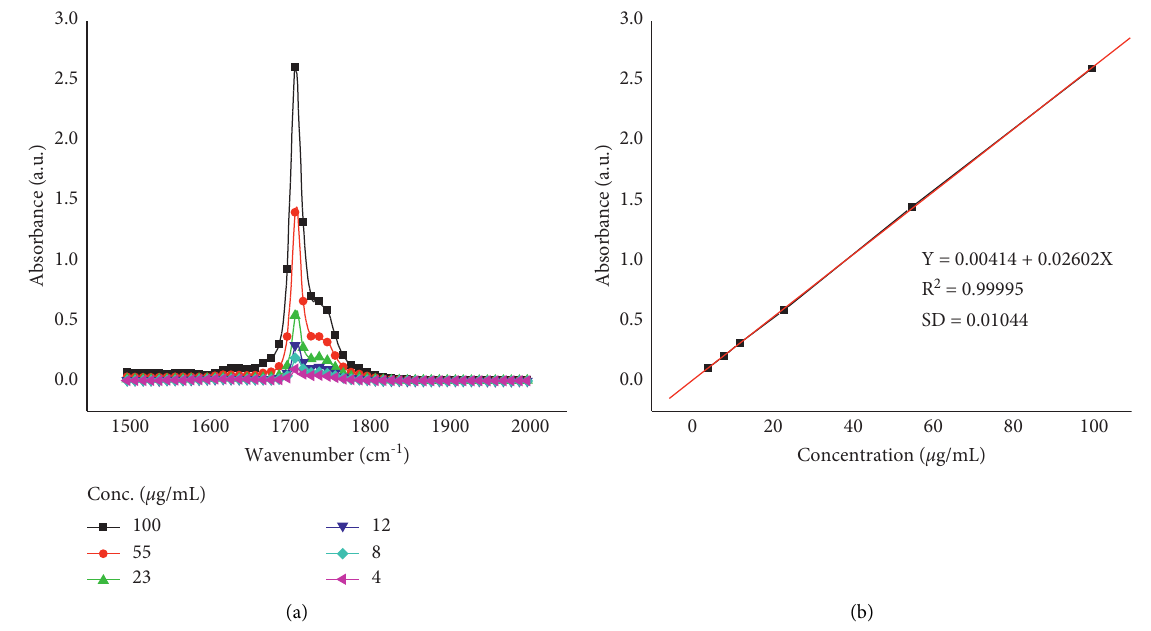
Figure 10: FTIR spectra of different concentrations of standard β -carotene in acetonitrile (a) and calibration plot (b). Table 3: Content ( µ g/g) of β -carotene in the pumpkin peel, flesh, and seed samples using the FTIR spectroscopic method. Sample